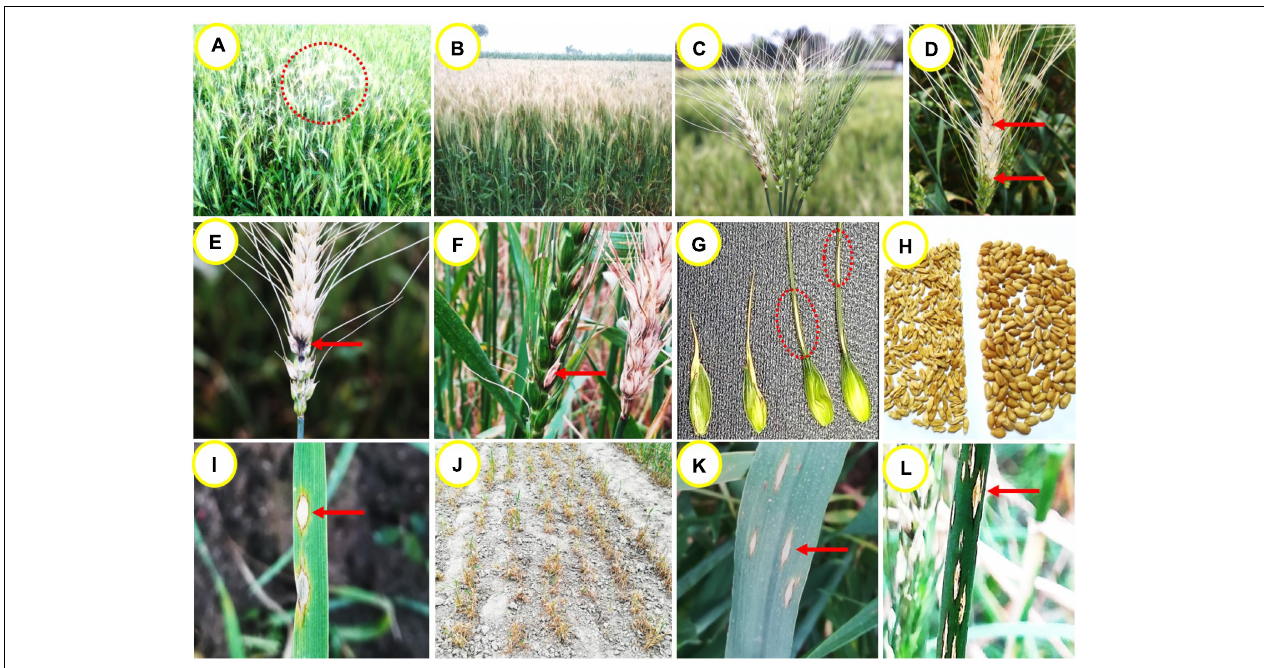
FIGURE 1 | Wheat blast symptoms on different parts of the plant. (A) initial symptoms of blast in wheat field in a patch, (B) infected field showing silvery bleached spikes with green canopy, (C) typical partial or full bleached spikes in field, (D) a partially bleached spike with multiple points of infection, (E) dark-gray sporulation of the fungus MoT on the rachis, (F) infected awns show brown to whitish discoloration, (G) infected glumes show elliptical lesions with white to brown center and dark gray margins, (H) severely shriveled or wrinkled blast affected vs. healthy grains of wheat, (I) typical eye-shaped lesions with gray or whitish centers surrounded by dark brown margins on seedling leaf, (J) a severely damaged seedling field affected by MoT infection, (K) typical eye-shaped or elliptical lesions on a mature leaf, and (L) elliptical or elongated lesions on blast-affected stem having white centers surrounded by brown or blackish margins.